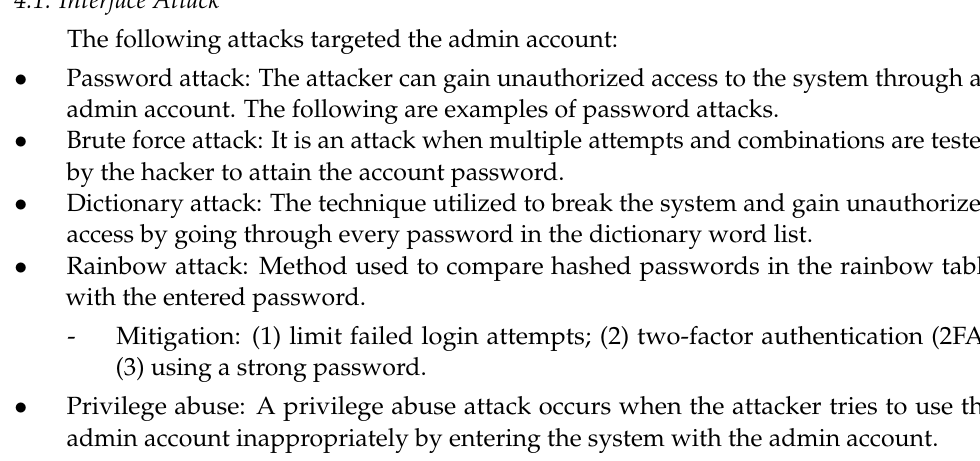
Figure 11. Threat modeling of the proposed solution